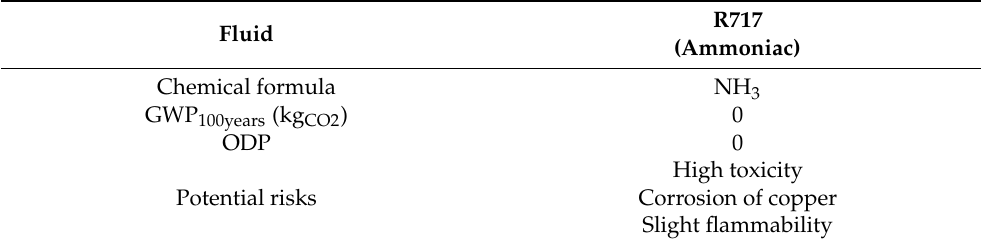
Table 4. Characteristics of